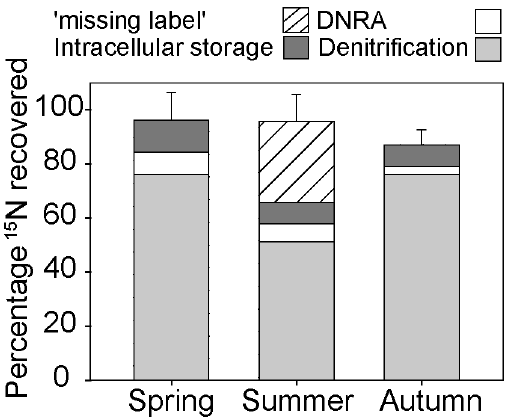
Figure 6. Average percentage of 15 N recovered in various pools. Denitrification denotes 15 N that was present as 29 + 30 N 2 , DNRA denotes 15 N that was present as 15 NH 4 + and intracellular storage represents 15 N which was present as either 29 + 30 N 2 or 15 NH 4 at the termination of the secondary incubation to which no additional 15 NO 3 was added. The ‘missing label’ fraction refers to the discrepancy between added 15 NO 3 2 , measured 15 NO 3 2 and 15 N 2 production (shown in Fig. 4). Error bars are overall SD